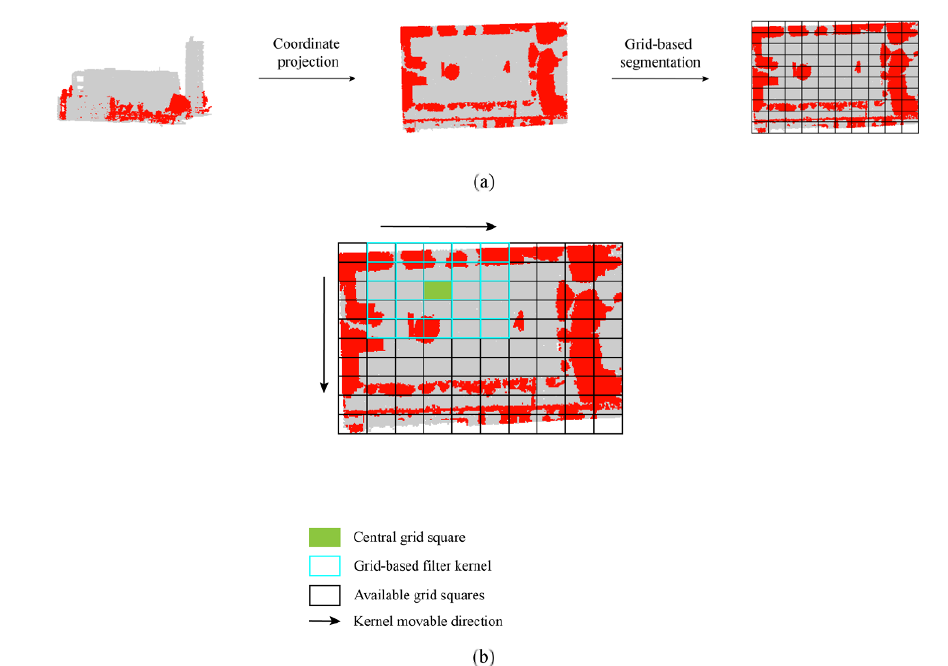
Figure 4. Grid-based elevation computation and filtering. ( a ) The illustrated point cloud data (left) and the 2D-projected data with grid segmentation (right). ( b ) The grid filter examining anomalies of calculated elevation values in grid